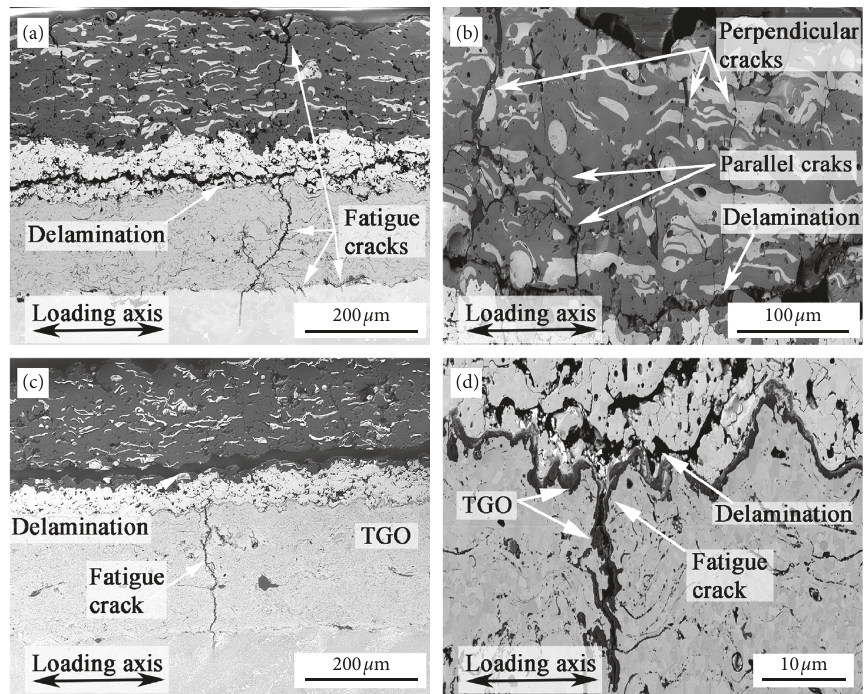
Figure 4: Degradation of the TEBC system. (a) Delamination of YSZ, ε hexacelsian upper layer, ε a � 0.30%; (c) degradation of TEBC after LCF, ε a � 0.15%; (d) TGO scale at the YSZ/CoNiCrAlY interface, ε a �